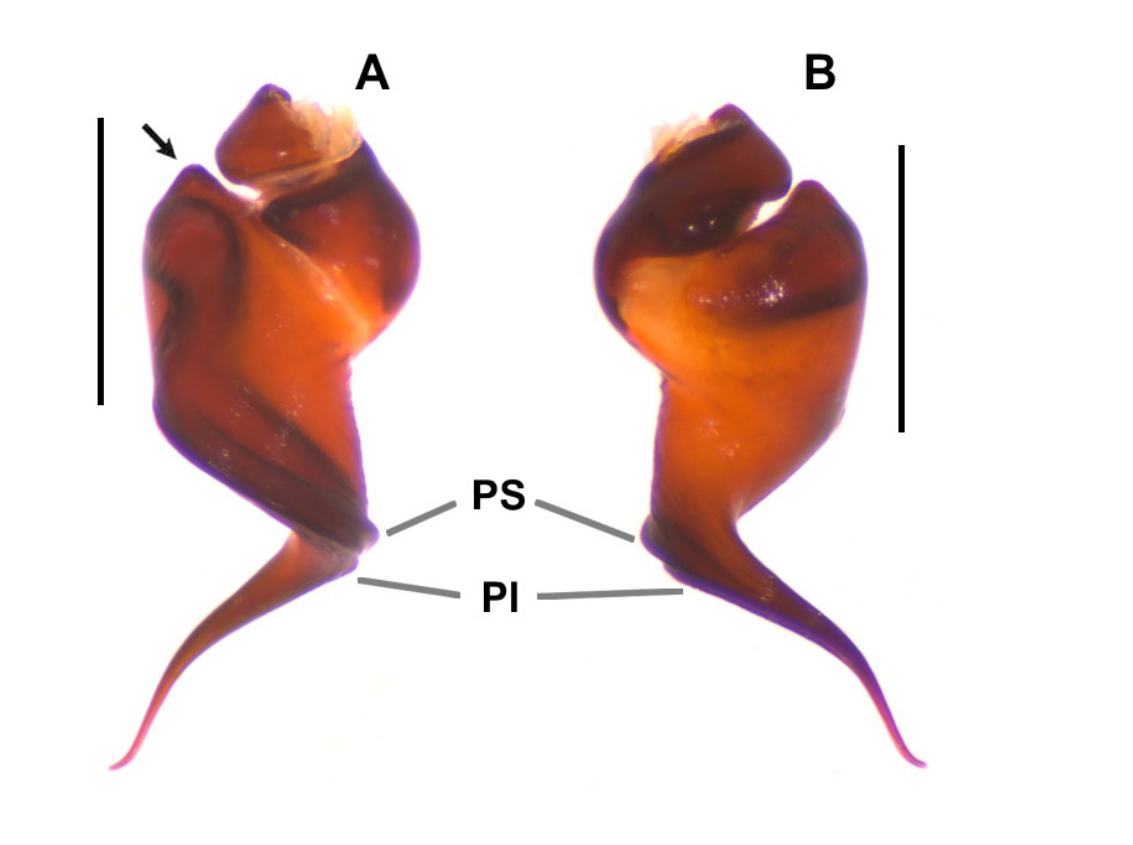
Fig. 4. Palpal bulb of Bistriopelma peyoi sp. nov., holotype, ♂ (MUBI 73). A . Prolateral view (arrow indicates the basal triangular projection on tegulum). B . Retrolateral view. Scale bars =